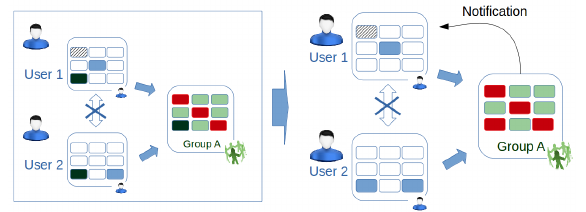
Figure 3. Cancelling a shared activity as a reaction to a global invariant